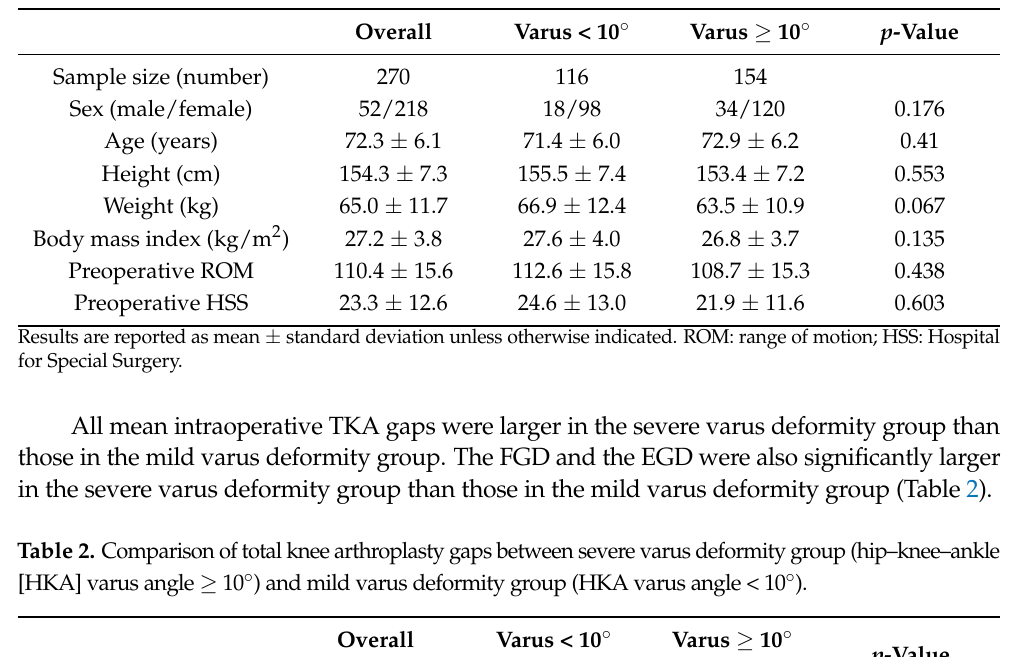
Table 2. Comparison of total knee arthroplasty gaps between severe varus deformity group (hip–knee–ankle [HKA] varus angle ≥ 10 ◦ ) and mild varus deformity group (HKA varus angle < 10 ◦ ). Overall Varus < 10 ◦ Varus ≥ 10 ◦